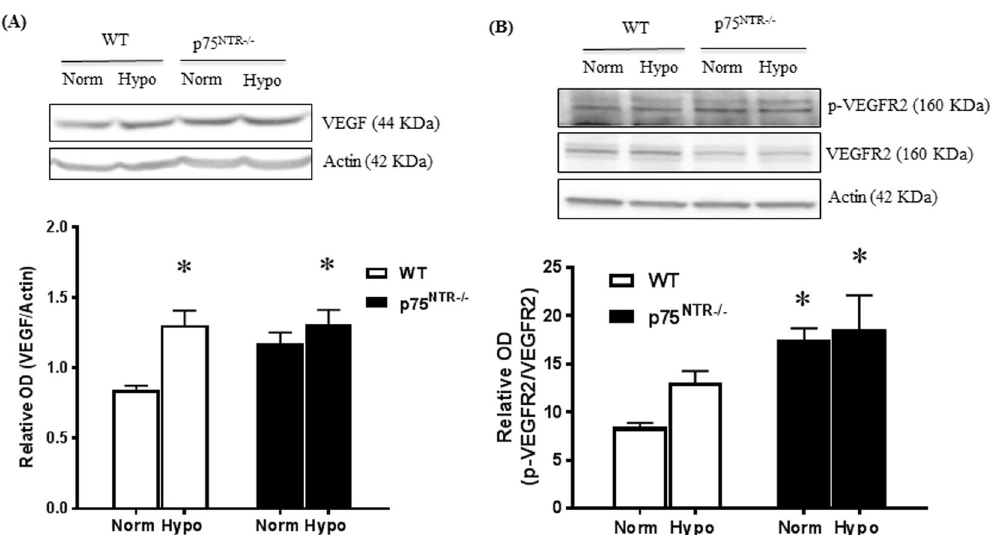
Figure 6. Deletion of p75 NTR preserved hypoxia-induced VEGF expression and VEGFR2 activation. ( A ) Representative Western blotting and bar graph of retinal VEGF protein expression from WT and p75 NTR − / − pups exposed to OIR at p14. Two-way ANOVA showed significant effect of hypoxia increasing VEGF both in WT and p75 NTR − / − pups ( * significant compared to WT normoxic group, p < 0.05, n = 6–12). ( B ) Representative Western blotting and bar graph of pVEGFR2 compared to its total protein VEGFR2 level. Two-way ANOVA showed marked gene deletion effect where p75 NTR − / − showed significant increase in pVEGFR2 under normoxia or hypoxia compared to WT-normoxic controls ( * significant compared to WT normoxic group using, p < 0.05, n =